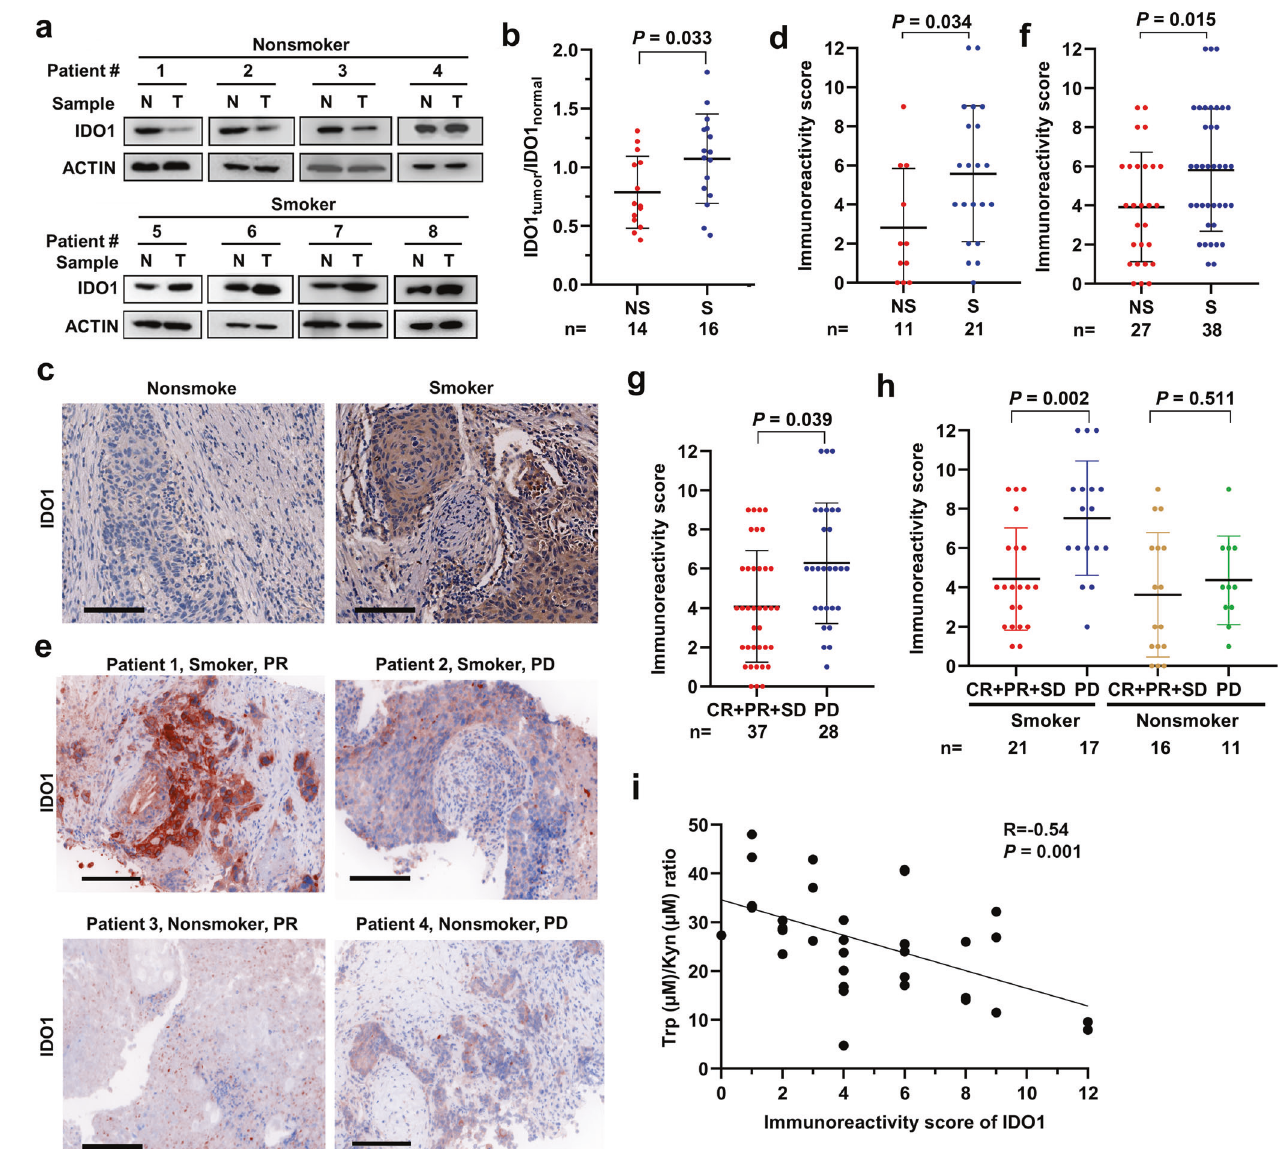
Fig. 3 Tobacco smoke is associated with higher IDO1 expression and worse response to anti-PD1 antibody in NSCLC patients. a – d Western blot ( a , b ) and immunohistochemistry ( c , d ) assays were conducted to detect the expression of IDO1 in lung tissues of smoker and nonsmoker patients with NSCLC. Densitometry analysis of western blot bands was performed, and the ratio of IDO1 in tumors (IDO1 tumor ) to IDO1 in normal tissues (IDO1 normal ) was calculated ( b ). The immunoreactivity score is shown ( d ). Scale bar = 100 μ m. e – i IDO1 immunohistochemistry staining results of lung tissues of NSCLC patients treated with the anti-PD1 antibody pembrolizumab. Scale bar = 100 μ m ( e ). Immunoreactivity scores of smoker and nonsmoker patients ( f ) and of those who achieved complete remission (CR), partial remission (PR), stable disease (SD), or progressive disease (PD) are shown ( g , h ). The correlation between the Trp/Kyn ratio and the IDO1 immunoreactivity score is shown ( i ). P values, Student ’ s t test. Error bars,